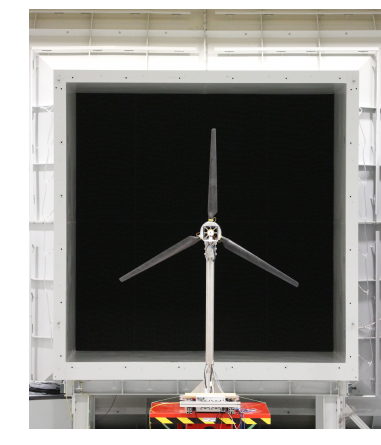
Figure 2. Turbine setup in